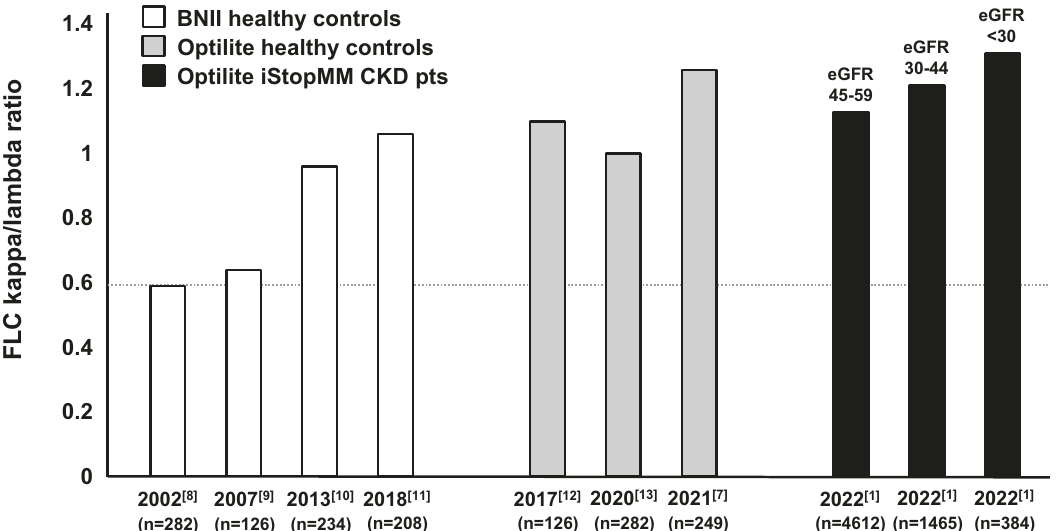
Fig. 1 Drift in Freelite FLC-ratio observed over the years. Shown are median Freelite FLC-ratios measured with BNII (white bars) and Optilite (gray bars) on large cohorts of healthy control blood bank donors. Superimposed in this fi gure are the median FLC-ratios of the CKD patients published in the iStopMM study (black bars) together with the eGFR value (mL/min/1.73 m 2 ). Underneath each bar the publication year plus reference, and the number of individuals per study are shown. The dotted line indicates the median FLC-ratio of 0.59 published in the landmark paper by Katzmann et al. in